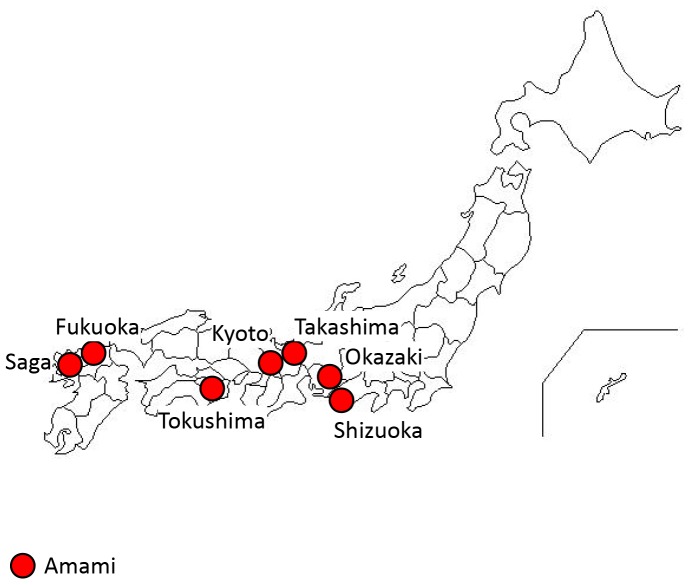
Location of the 8 study regions.